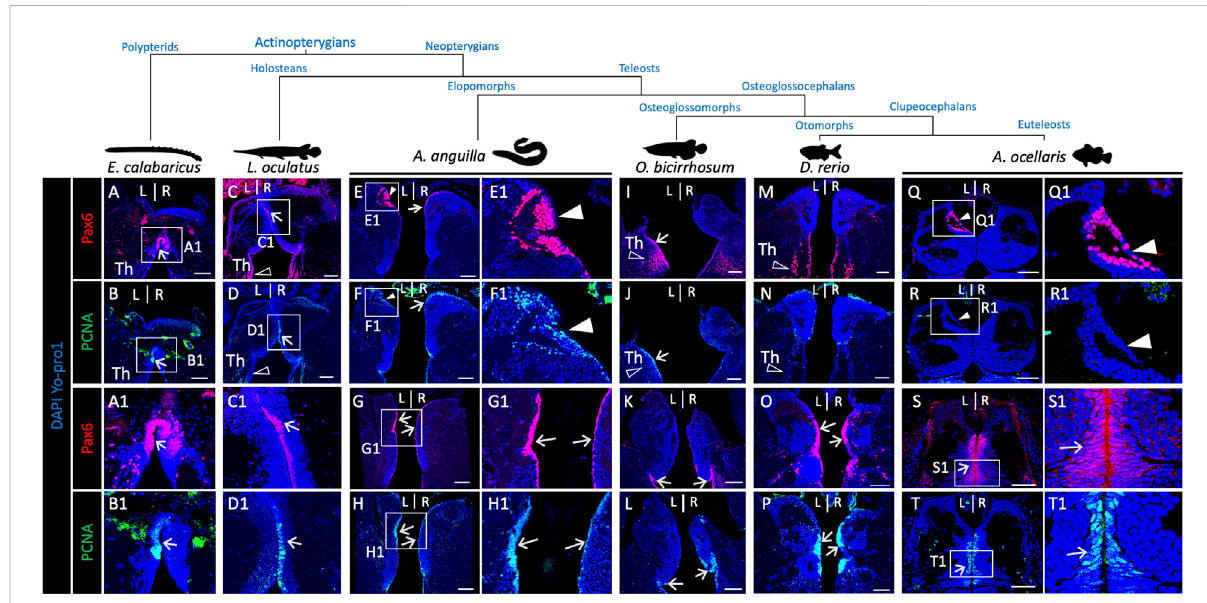
FIGURE 6 Pattern of presence/absence of an asymmetric pax6 dorsal nucleus in actinopterygians. (A-R) Transverse sections of habenulae in the reed fi sh E. calabaricus [ (A,B) ; 20 cm juvenile], spotted gar L. oculatus [ (C,D) ; 8.5 cm juvenile], European eel A. anguilla [ (E – H) ; yellow resident stage], silver arowana O. bicirrhosum [ (I – L) ; 7 cm juvenile], zebra fi sh D. rerio [ (M,P) ; adult] and false clown fi sh A. ocellaris [ (Q – T) ; stage 6], following IHC with antibodiesdirectedagainstpax6 (A,C,E,I,M,Q,G,K,O,S) andPCNA (B,D,F,J,N,R,H,L,P,T) . (A1 – H1) , (Q1 – T1) arehighermagni fi cationviewsofthe territories boxed in (A – H) , (Q – T) . Arrows point towards pax6 and PCNA positive neural progenitors, white arrowheads point to left restricted pax6 positive and PCNA negative dorsal nuclei observed in the European eel and false clown fi sh as in the Atlantic salmon. Opened